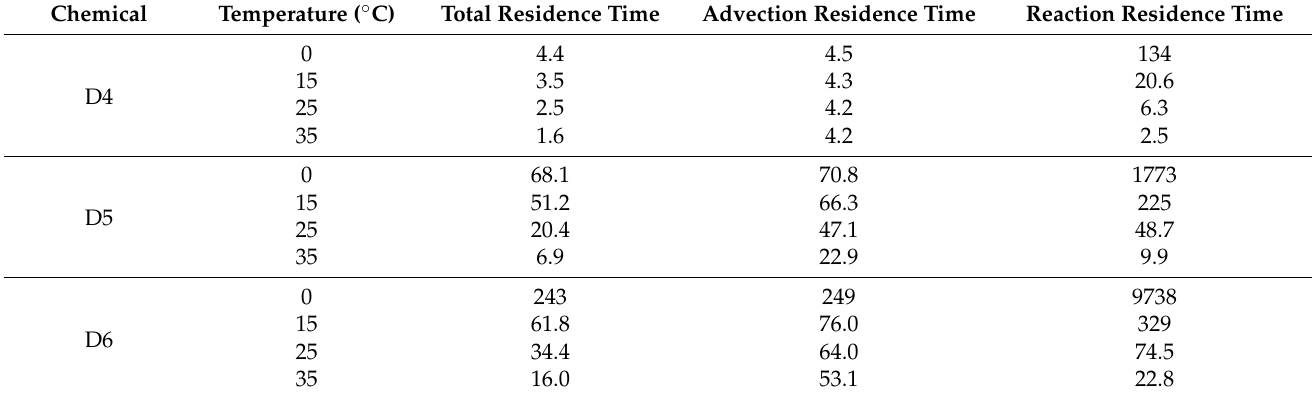
Table 5. Residence time (d) of CMSs (D4–D6) in the environmental system of Beijing.